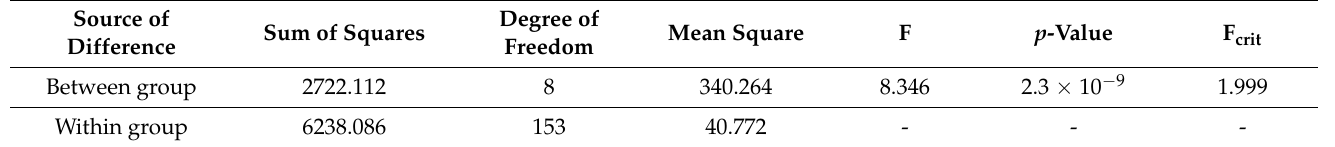
Table 7. The results of the ANOVA of the compressive strain on top of the